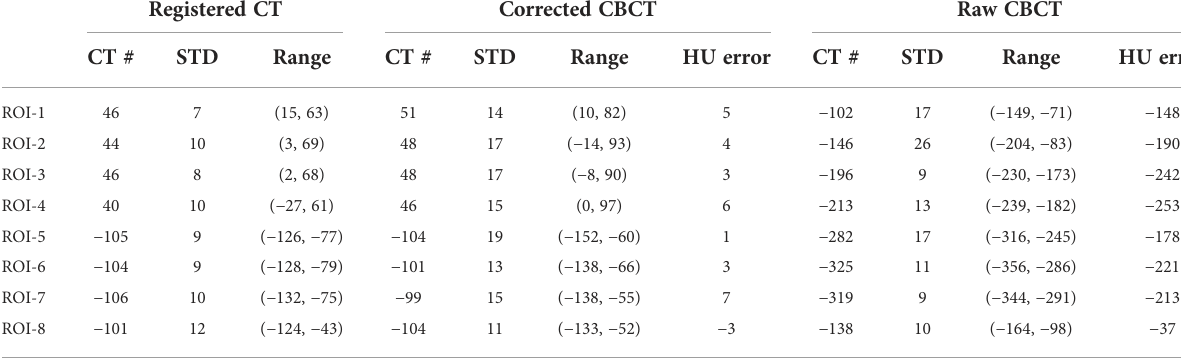
TABLE 4 The CT number comparison of the eight ROIs in Figure 6 (unit: HU).